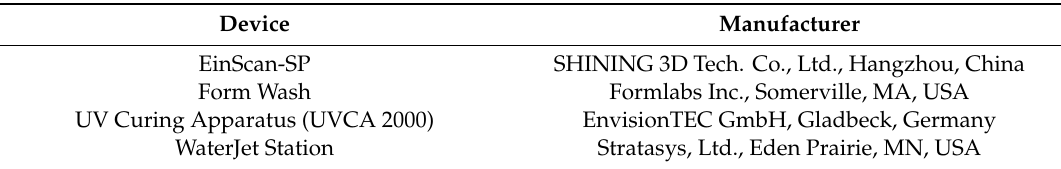
Table 2. Additional devices and